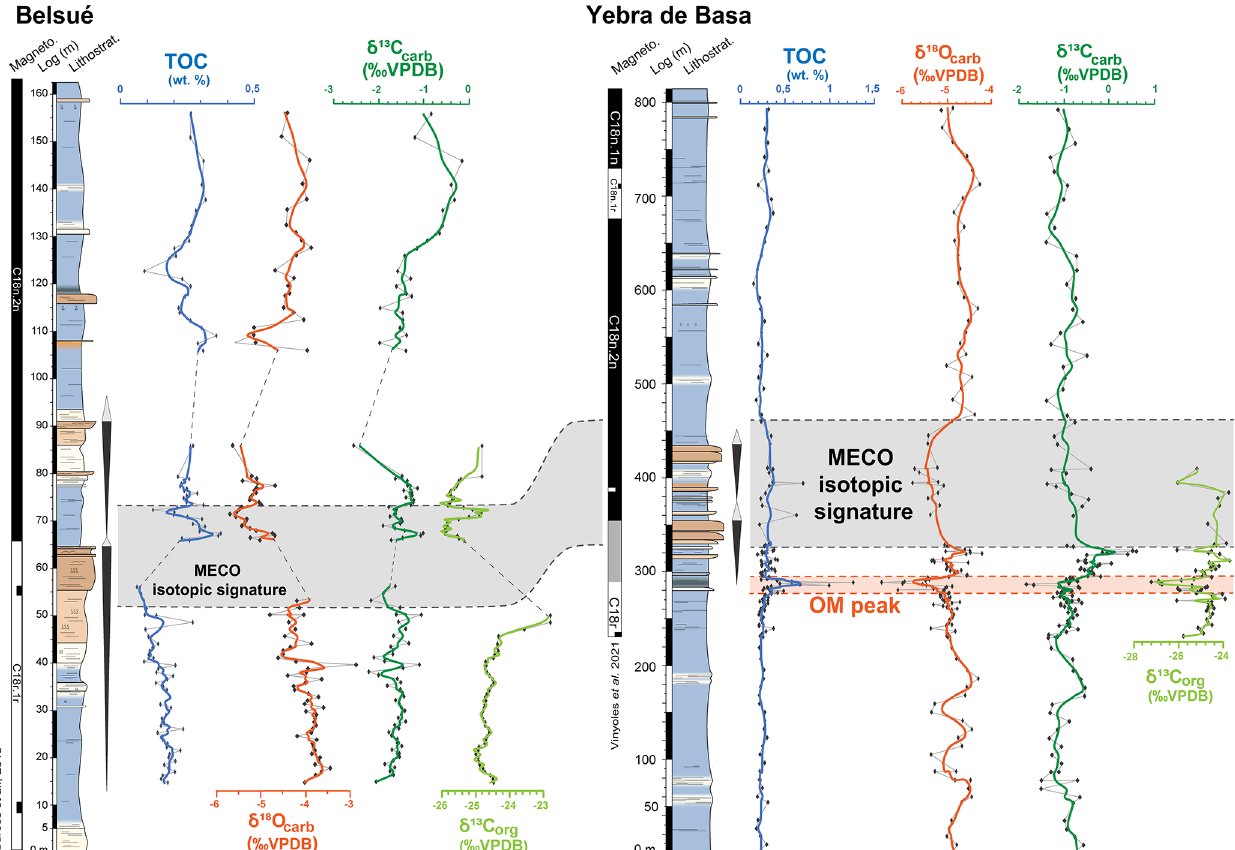
Figure 7. Stratigraphic logs of Belsué and Yebra de Basa including the results of total organic carbon (TOC), carbonate stable iso- topes ( δ 18 O carb and δ 13 C carb ), and organic carbon stable isotopes ( δ 13 C org ). The two progradation–retrogradation cycles referred to in the text are drawn next to the stratigraphy; note the scale change. Highlighted in grey is the MECO isotopic signature, and highlighted in pale red is the OM-rich interval coeval to the MECO thermal peak. The coloured broad lines correspond to the three-point moving av- erage, whilst the central part of the Yebra de Basa section has a seven-point moving-average curve due to the high sampling resolution. Magnetostratigraphic logs from Vinyoles et al. (2021) and Garcés et al. (2014). The dashed lines represent non-sample